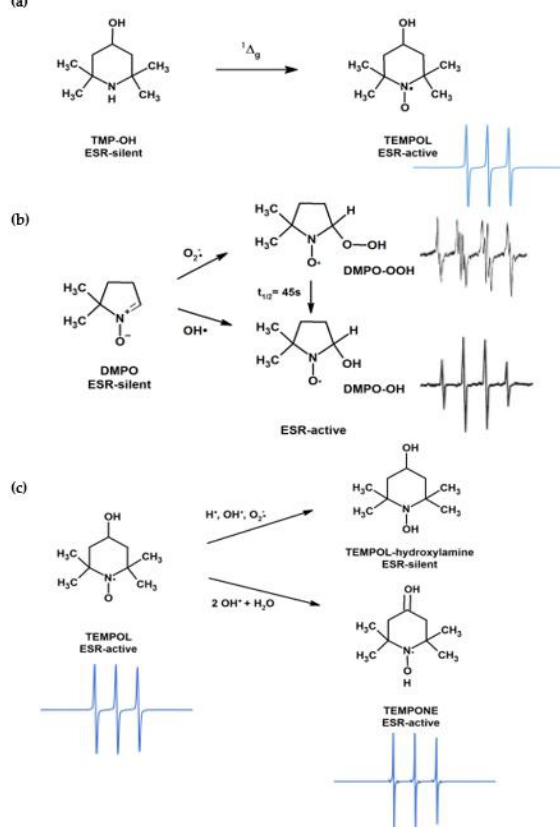
Scheme A2 . Schematic representation of typical reactions of ROS with the spin-traps, TMP-OH and DMPO. ( a ) Scavenging of excited singlet oxygen ( 1 Δ g ) by TMP-OH results in appearing of the